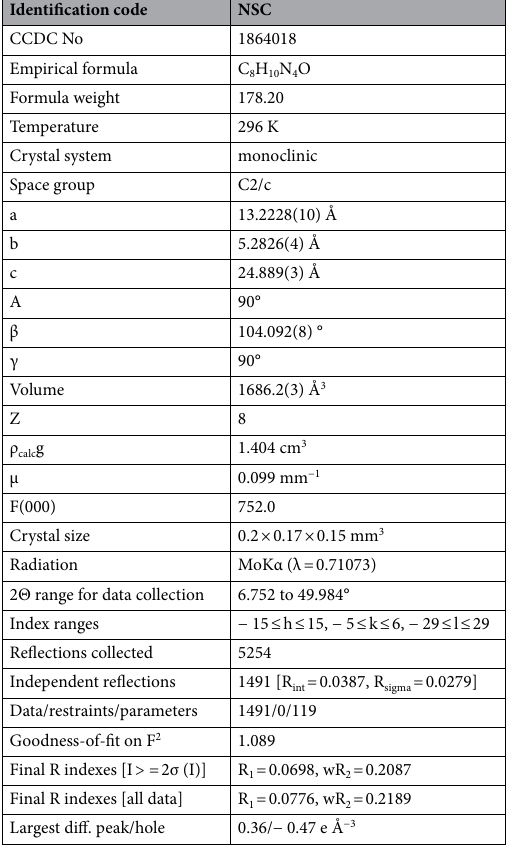
Table 8. Crystal data and structure refinement of compound